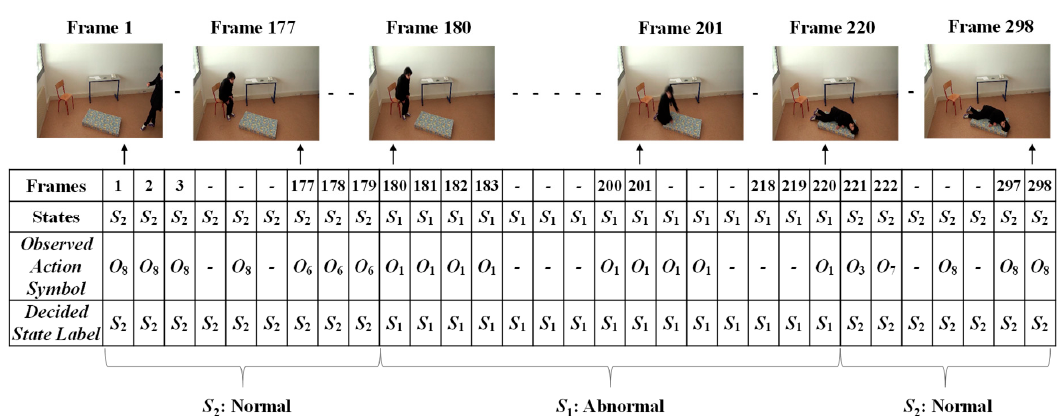
Figure 17. Results for deciding on the sequential abnormal and normal states for Ms. TWO (Video 2).